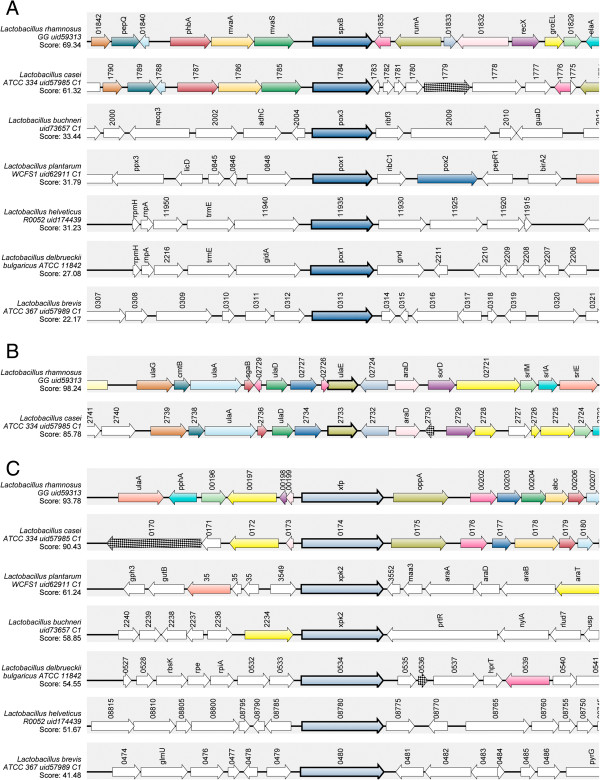
Schematic diagram for genome regions surrounding spxB, ulaE and xfp locus in diverse lactobacilli. (A), spxB. (B), ulaE. (C), xfp. Gene syntenies were explored using the web service SyntTax [27]. TDF-derived protein sequences were used to query the selected genomes. Genes corresponding to query proteins are drawn in bold. A consistent color coding allows identification of orthologs and paralogs. Some gene names are indicated. Normalized BLAST scores are visualized. Reference organisms: L. rhamnosus GG, L. casei ATCC 334, L. buchneri CD034, L. plantarum WCFS1, L. helveticus R0052, L. delbrueckii subsp. bulgaricus ATCC 11842 and L. brevis ATCC 367. For ulaE, a conserved gene order was observed only in L. rhamnosus GG and L. casei ATCC 334.